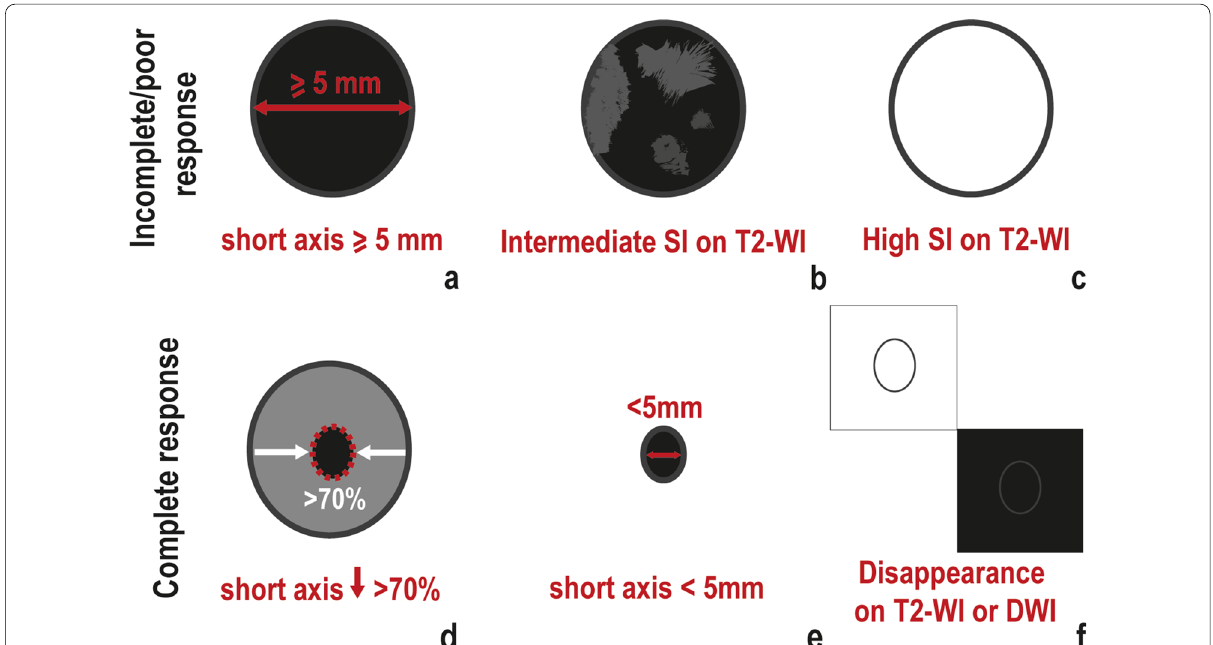
Fig. 3 Mesorectal lymph nodes. An incomplete/poor lymph node response to NAT may be characterised by ( a ) a short axis ≧ 5 mm after NAT; b residual intermediate “tumour” signal intensity or heterogeneity on T2-WI; c Persistent high signal intensity “mucin” on T2-WI. When a lymph node presents with a complete response after NAT, a reduction in short axis superior to 70% at re-staging T2-WI may be observed ( d ). Also, according to ESGAR guidelines, lymph nodes with short axis < 5 mm on re-staging T2-WI ( e ) should be considered negative. The positive predictive value for a complete response in lymph nodes that disappear on T2-WI or DWI ( f ) is close to 100%. “Near-complete” responders should have no signs of persistent disease in lymph nodes and as such criteria are the same as for complete